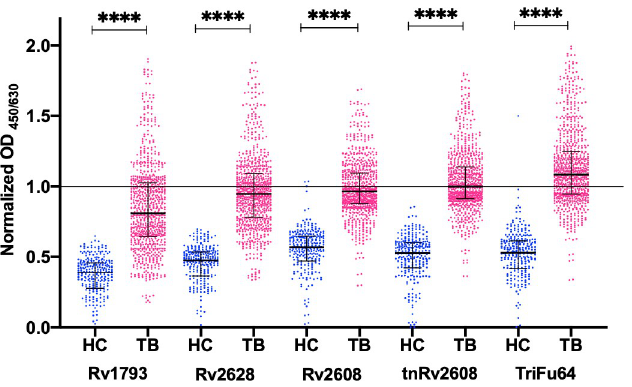
Fig 4. Individual antigens, truncated protein and the fusion protein are differentially recognized by TB patient samples. Scatter plot of normalized OD 450/630 values showing plasma sero-reactivity of 400 TB patients (TB) and 141 Healthy Controls (HC) against single, truncated and fusion proteins.